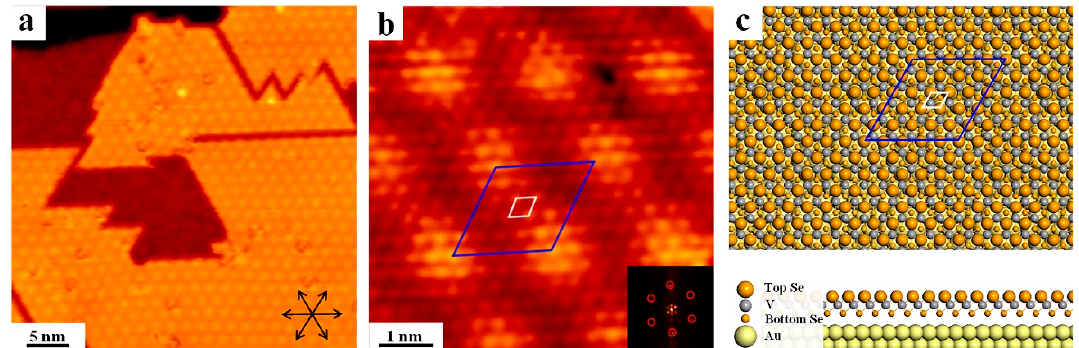
Figure 1. ( a ) The overview STM of the V selenide grown on Au(111). Black arrows: high-symmetry directions of the Au(111) substrate. ( b ) High-resolution STM with the moiré pattern resolved. Unit cells of the V selenide as well as the moiré pattern are indicated by colored rectangles, while FFT is shown inset indicating the periodicity of moiré structure. ( c ) DFT predicated configuration of VSe 2 on Au(111) with top and side views. Au: yellow; Se: green; V: red. Scanning parameters: ( a ) U bias = − 1.0 V, I tunneling (t) = 0.6 nA; ( b ) U bias = − 1.2 V, I t = 1.2 nA.